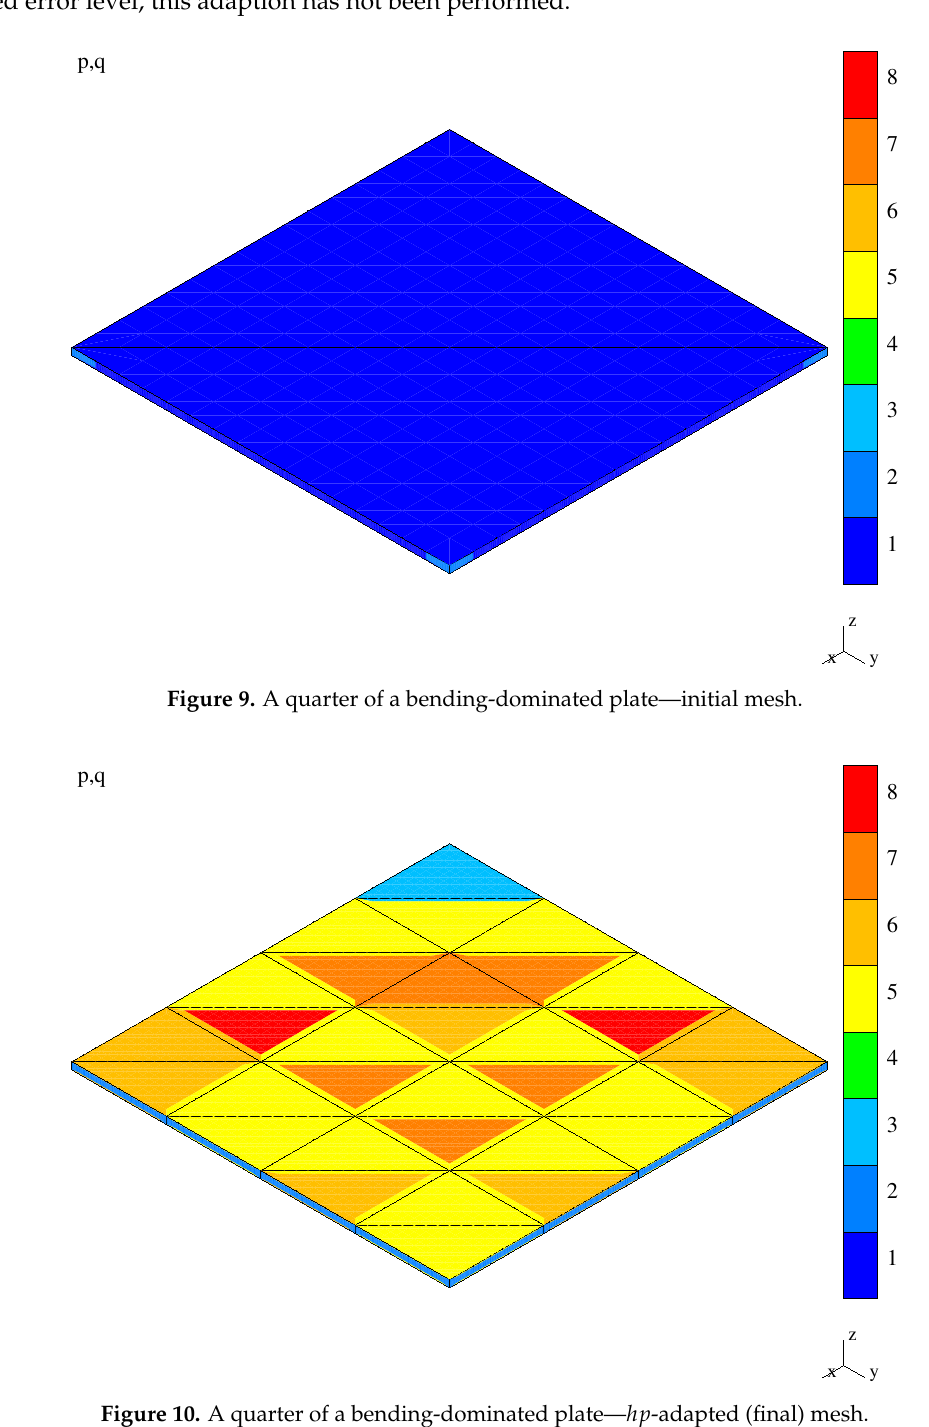
Figure 10. A quarter of a bending-dominated plate— hp -adapted (final)